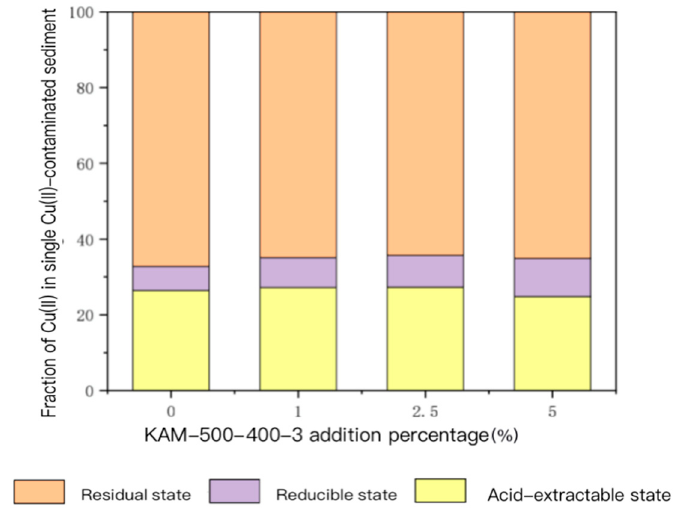
Figure 4. Fraction of Cu(II) in single Cu(II)-contaminated sediment determined through BCR sequential extraction under different addition percentages of KAM500-400-3.